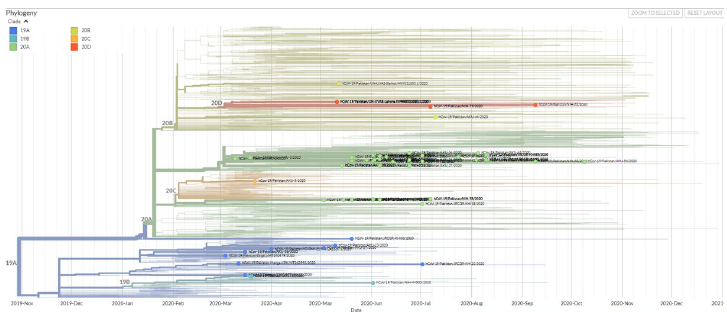
Fig 2. Time-resolved phylogenetic distribution of genomic epidemiology of SAR-CoV-2 focused on Asian subsampling (Screenshot of the current Nextstrain display in SVG format are protected by CC-BY license). Tree option layout is selected as rectangular, branch length is set as time interval while branch labels on the basis of phylogenetic clades (19A, 19B, 20A, 20B, 20C and 20D) showing SARS-CoV-2 genomes from Pakistan highlighted in